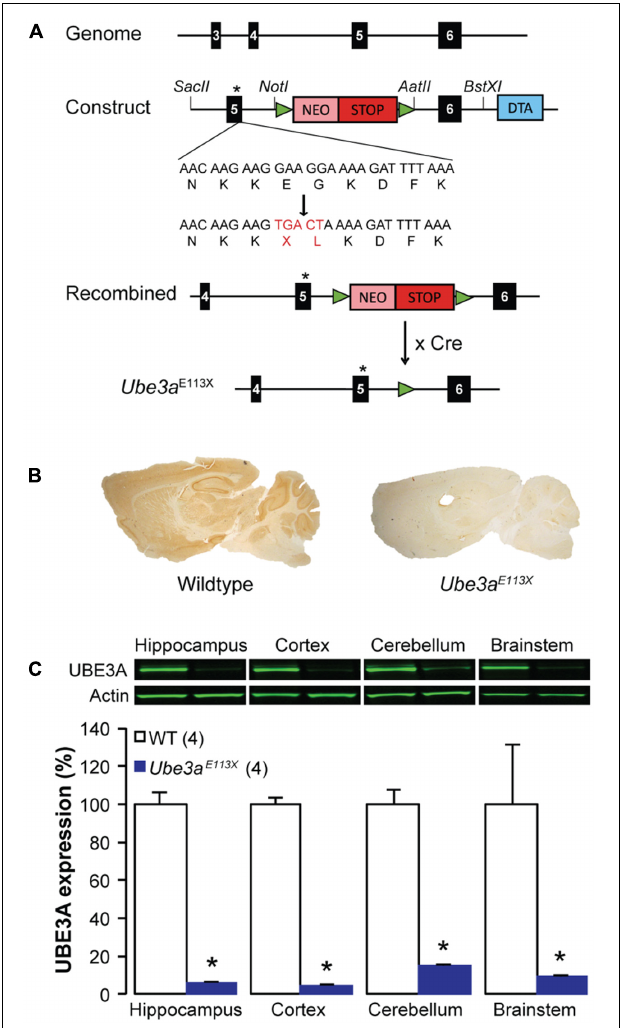
FIGURE 1 | Characterization of the Ube3a E113X mice. (A) Schematics depicting the generation of the Ube3a E113X mouse model starting with the insertion of the p.Glu113X and p.Gly114Leu mutations at the end of exon 5, and insertion of a floxed NEO-stop cassette into intron 5–6 of Ube3a . Cre-mediated recombination leads to removal of the floxed stop-NEO cassette. Black boxes correspond to Ube3a coding exons and green triangles represent the LoxP sites. (B) Immunohistochemical UBE3A stainings from a Ube3a E113X mouse and a WT littermate. (C) Western blot analysis showing 80–90% reduction of the UBE3A protein in the hippocampus, cortex, cerebellum and brainstem of Ube3a E113X mice compared to WT ( n = 4 animals for both C57BL/6J WT and Ube3a E113X ). ∗ Indicates p < 0.0001 for hippocampus, cortex, cerebellum, and p = 0.03 for